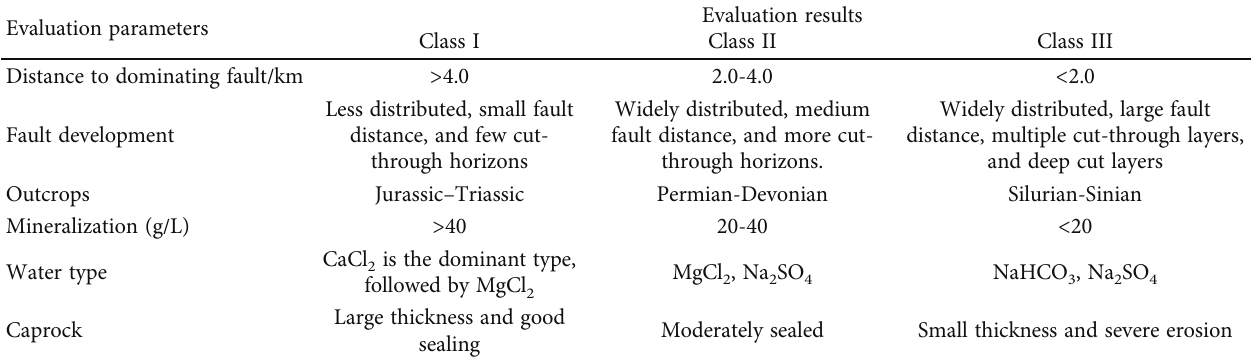
Table 4: The comprehensive evaluation system of hydrocarbon preservation conditions of Triassic